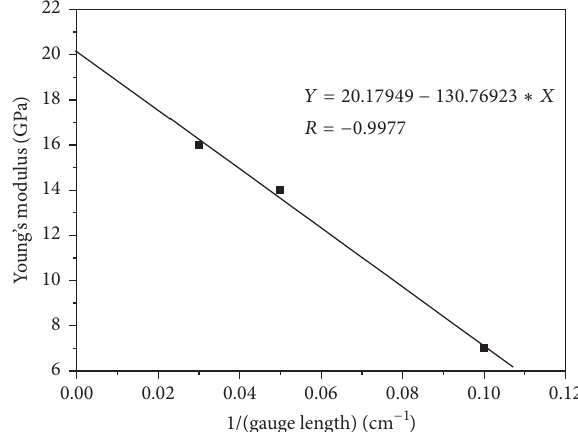
Figure 7: Extrapolation of the Young’s modulus as a function of gauge length to estimate the true Young’s modulus for solid-state drawn PET after the 2nd drawing ( 𝜆 = 9.7 ).